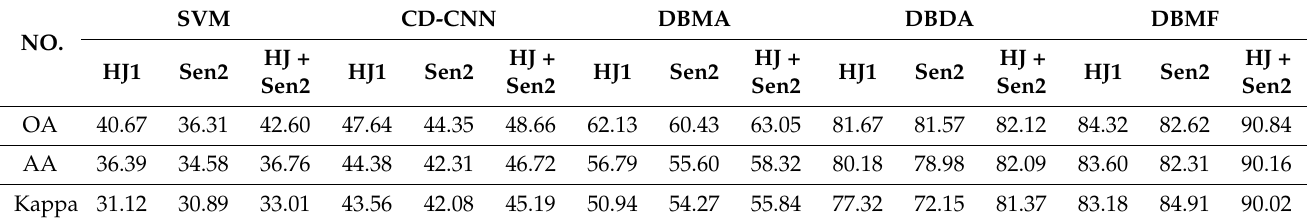
Table 3. Classification accuracy (%) comparison of three areas.